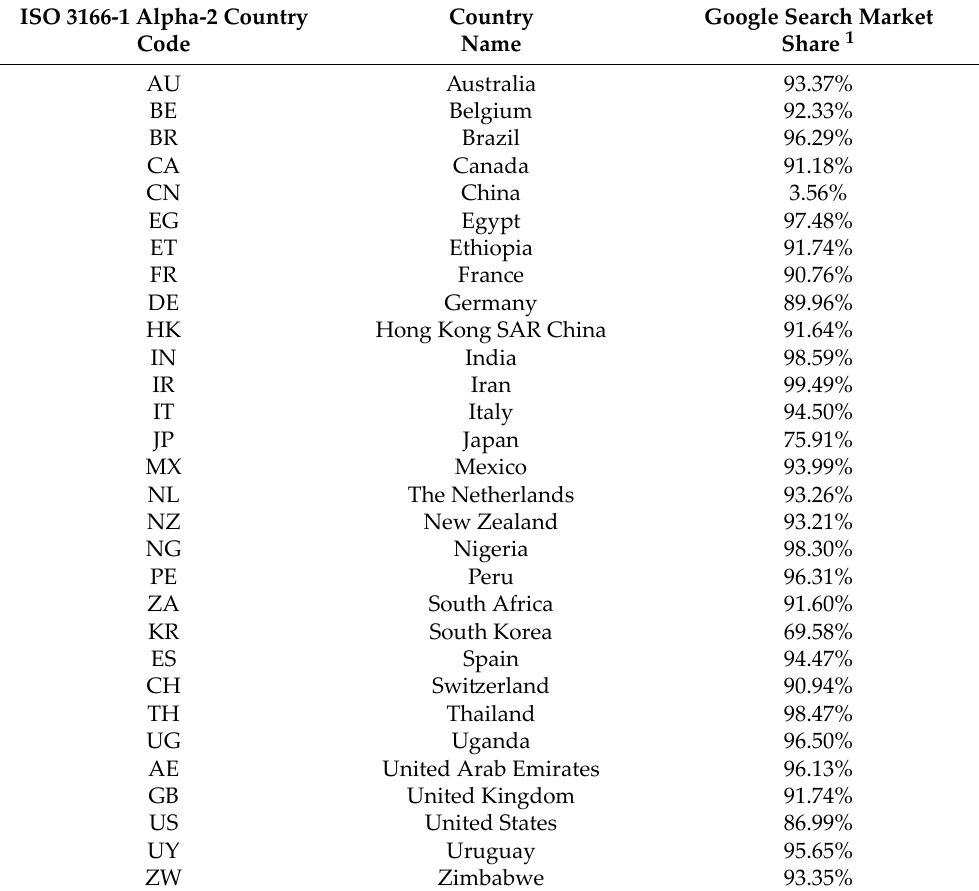
Table 1. List of countries included in the comparison of pre‑ and post‑implemented changes to the Google Health Trends